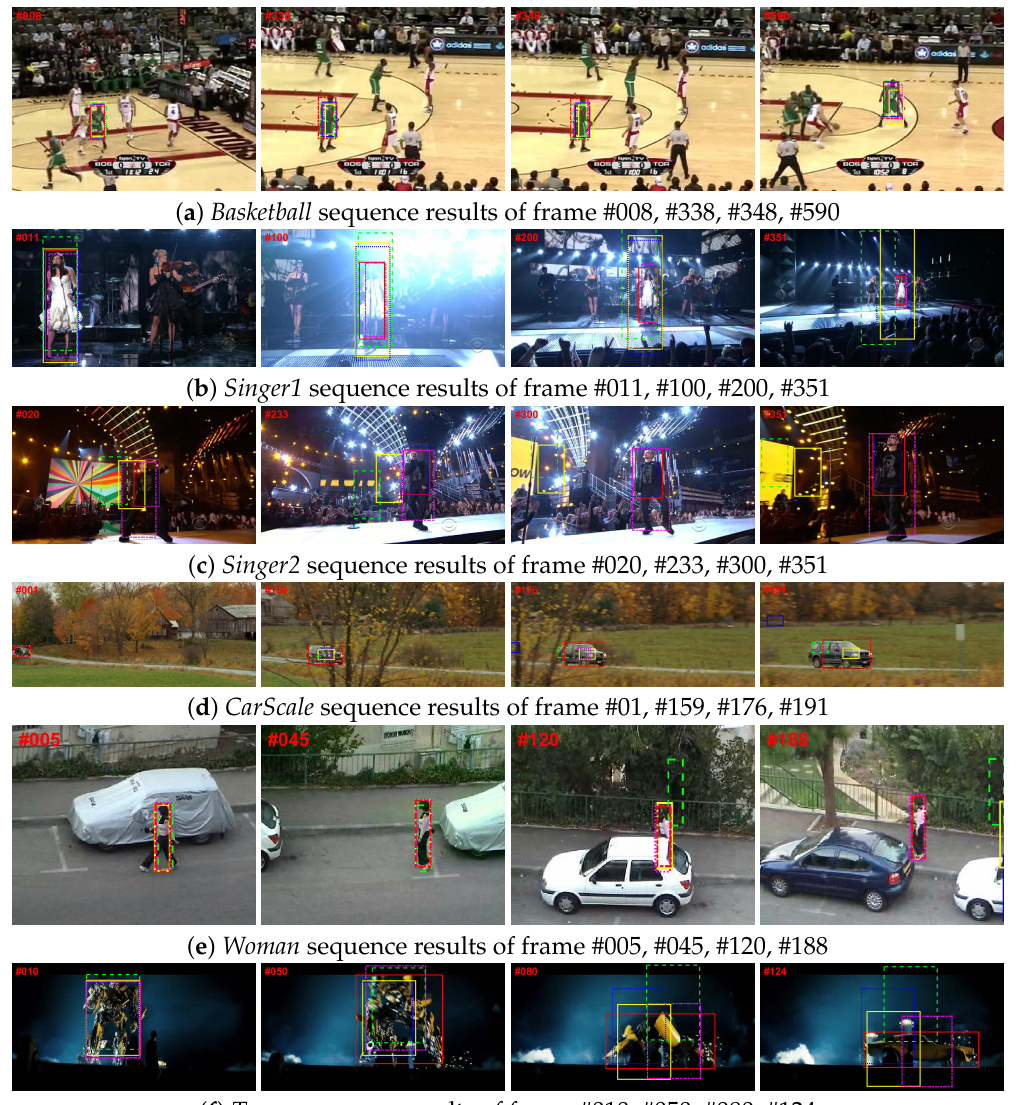
Figure 7. Comparison of the proposed approach with state-of-the-art trackers in illumination changes sequence. The results of distractor-aware tracker (DAT) [7], adaptive color attributes tracker (ACT) [6], kernelized correlation filter (KCF) [12], Staple [14], and the proposed approach are represent by green, yellow, blue, magenta, and red